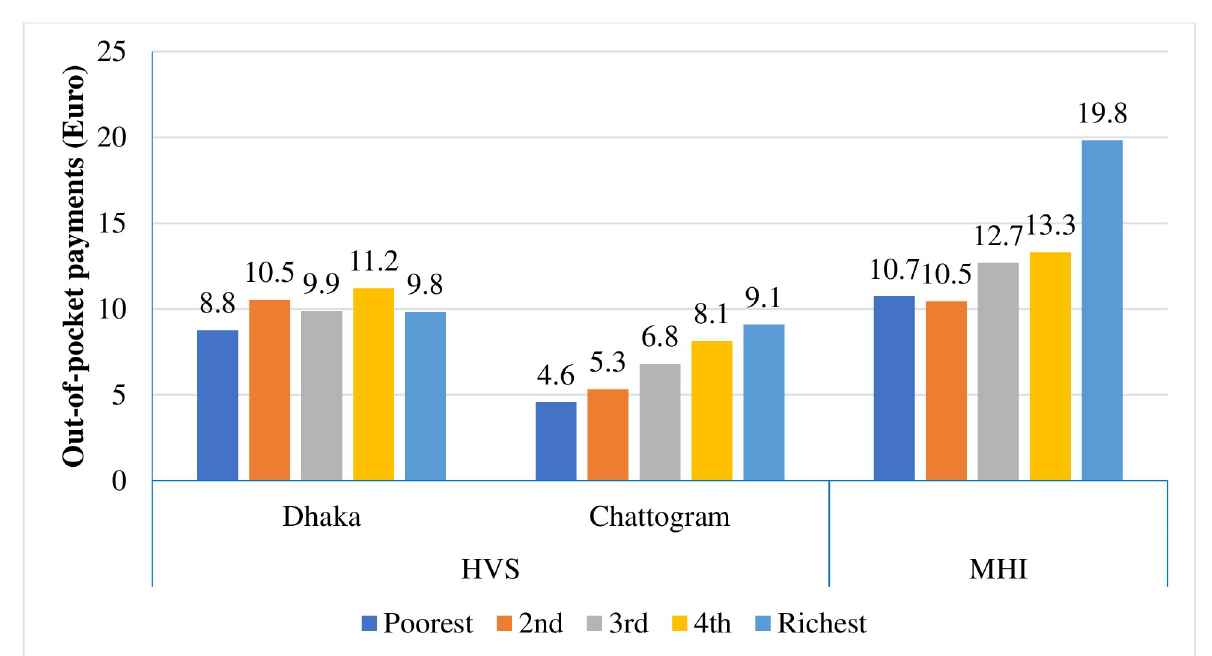
Fig 3. Average out-of-pocket payment (Euro) across socioeconomic quintiles.